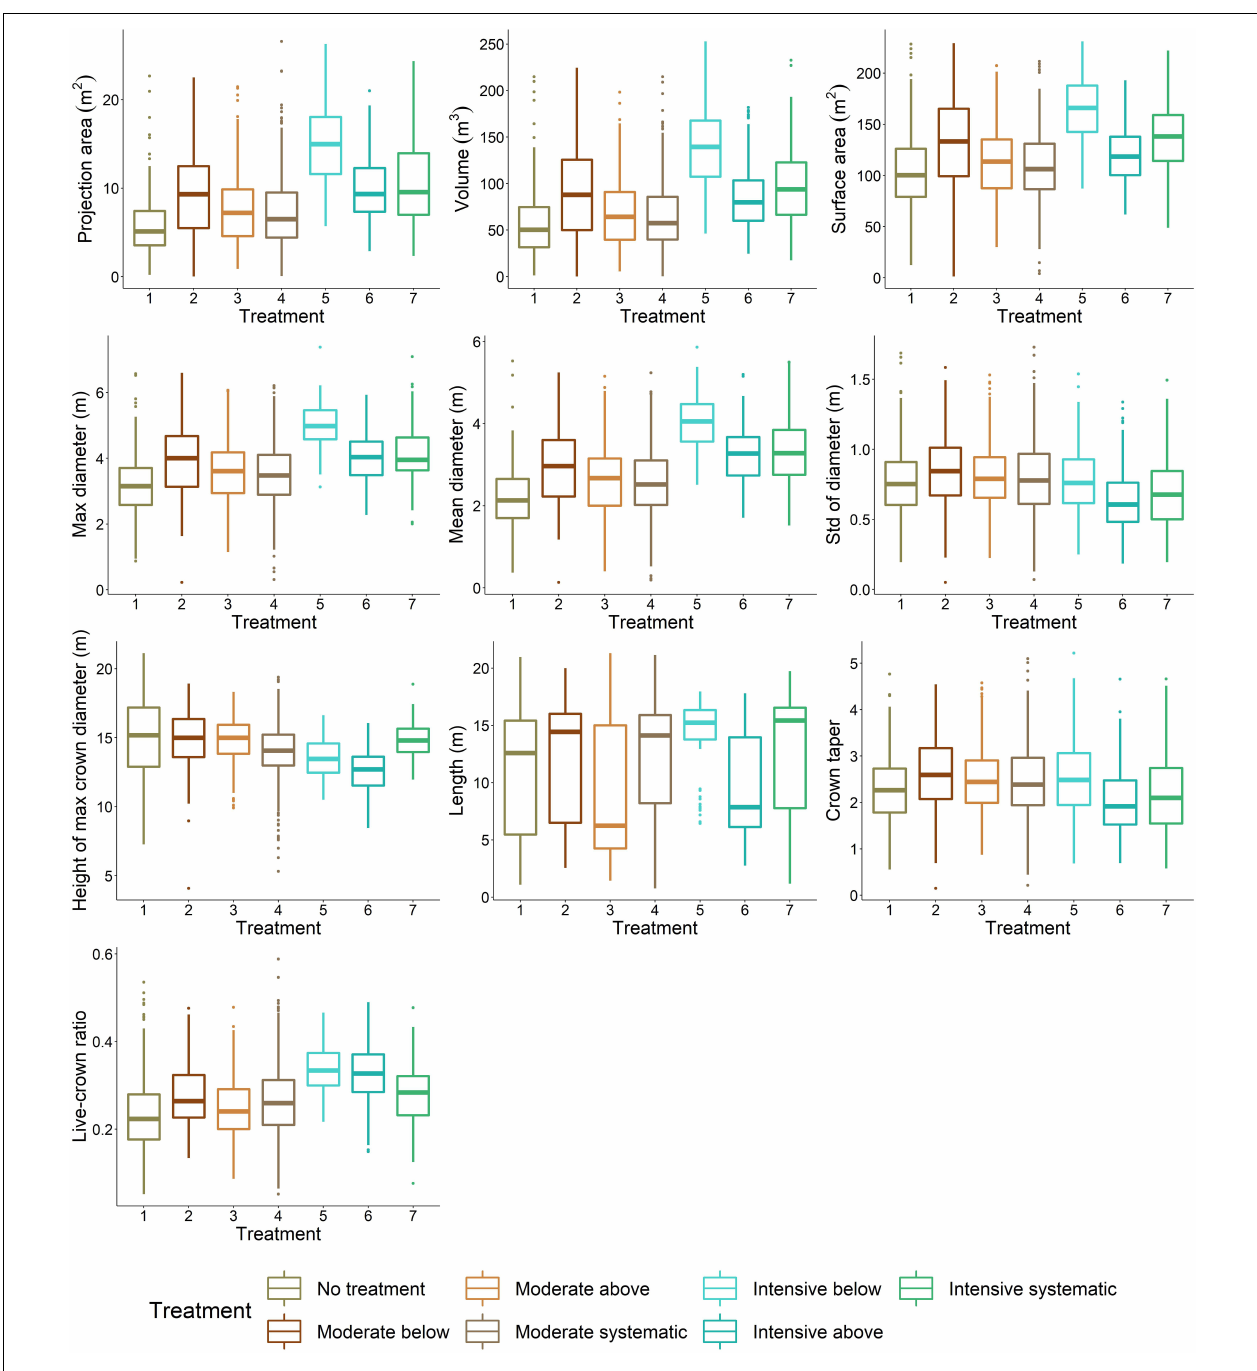
FIGURE 4 | Variation in crown attributes between thinning treatments. 1, no treatment (i.e., control); 2, moderate thinning from below; 3, moderate thinning from above; 4, moderate systematic thinning from above; 5, intensive thinning from below; 6, intensive thinning from above; and 7, intensive systematic thinning from